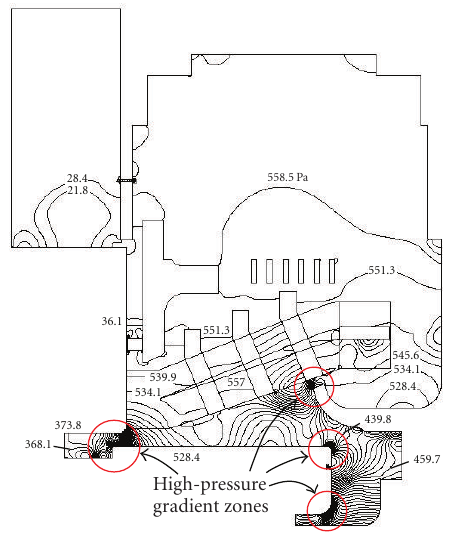
Figure 5: Static pressure contours at the end-winding region with circled high-pressure gradient.